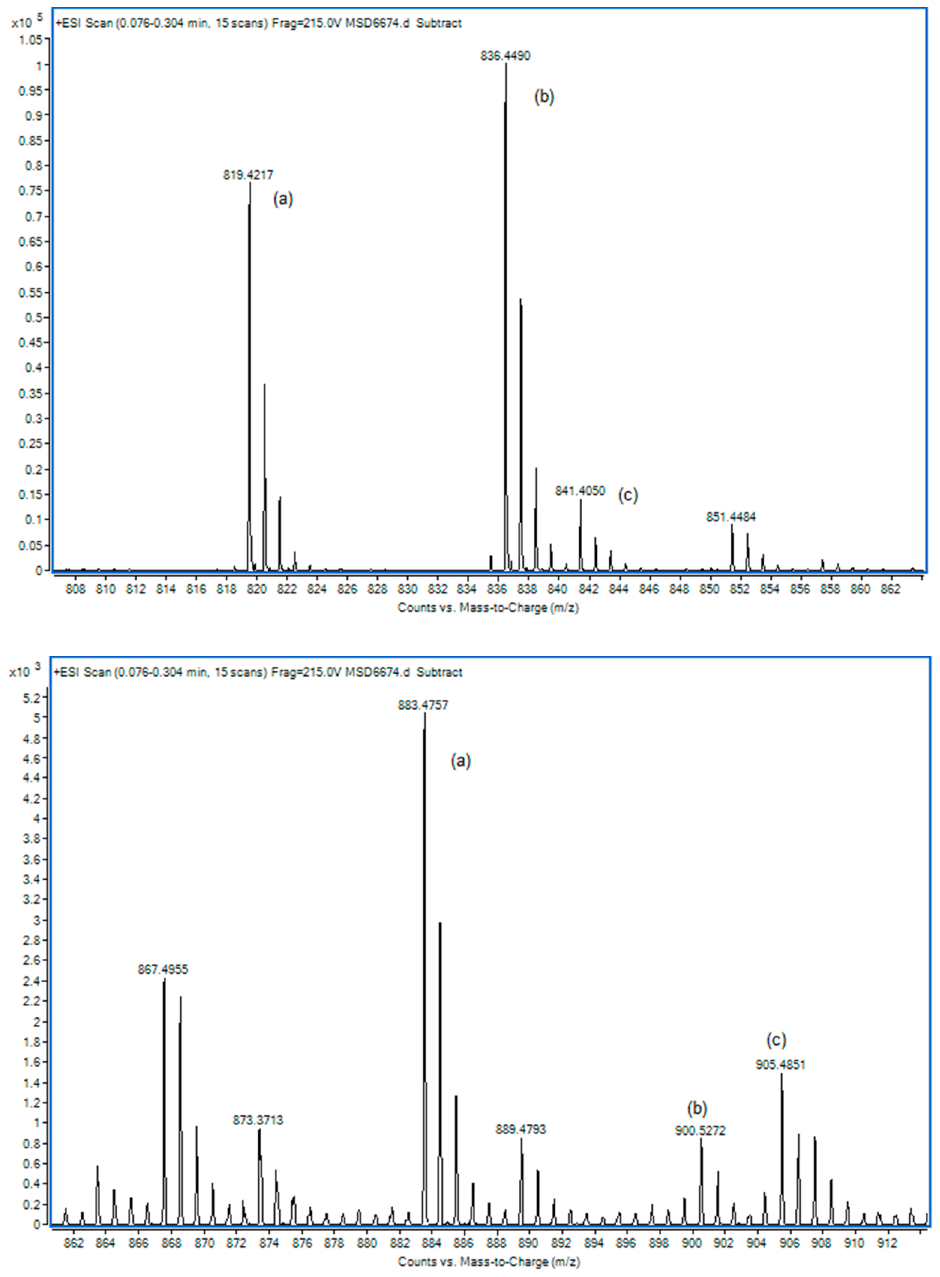
Figure 1. ( top ) Positive ion ESI-MS of compound ( 3 ); 819.4217 (M + H + ) ( a ) (MW819), ( b ) (MW836) X + NH 4+ and ( c ) (MW 841) X + Na + ( bottom ) Positive ion ESI-MS of compound ( 4 ); 883.4757 ( a ) (MW883) M + H + , ( b ) (MW900) M + NH 4+ and ( c ) M + Na + .